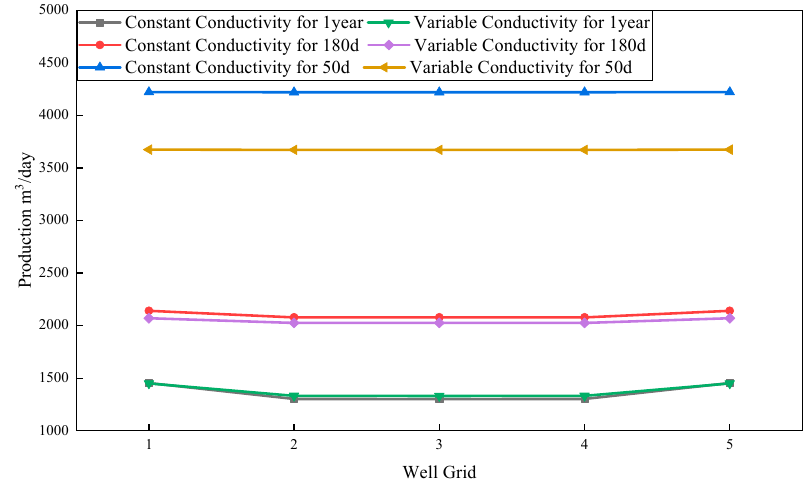
Figure 8. Near well flow distribution.